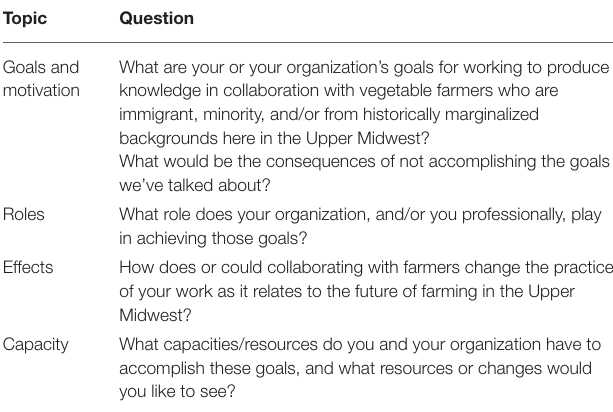
TABLE 1 | Question list for semi-structured